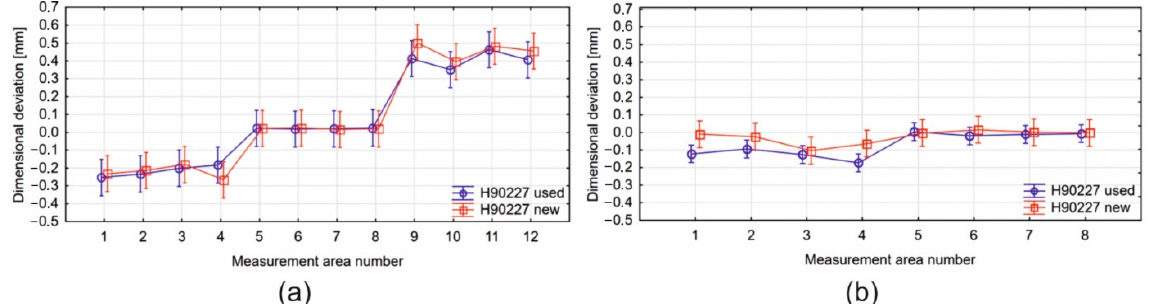
Figure 28. Results of ANOVA analysis for the porthole die 2: die core/bridge part ( a ) and die disc/insert ( b ).